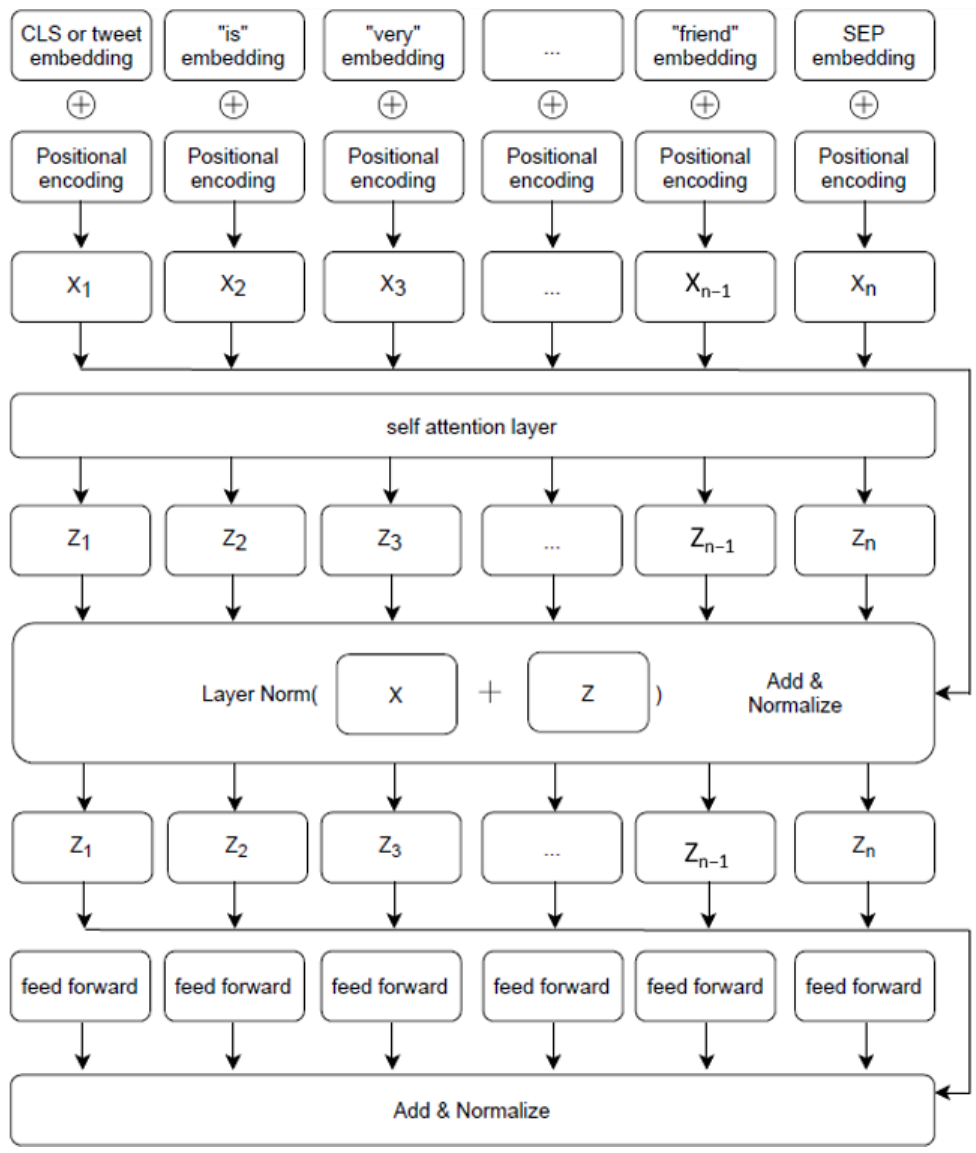
Figure 4. This is a representation of one encoding layer mentioned in Figure 3. There are twelve of these encoding layers in the final architecture. The word embedding of each token passes through these encoding layers, and at the end, we obtain the transformed word